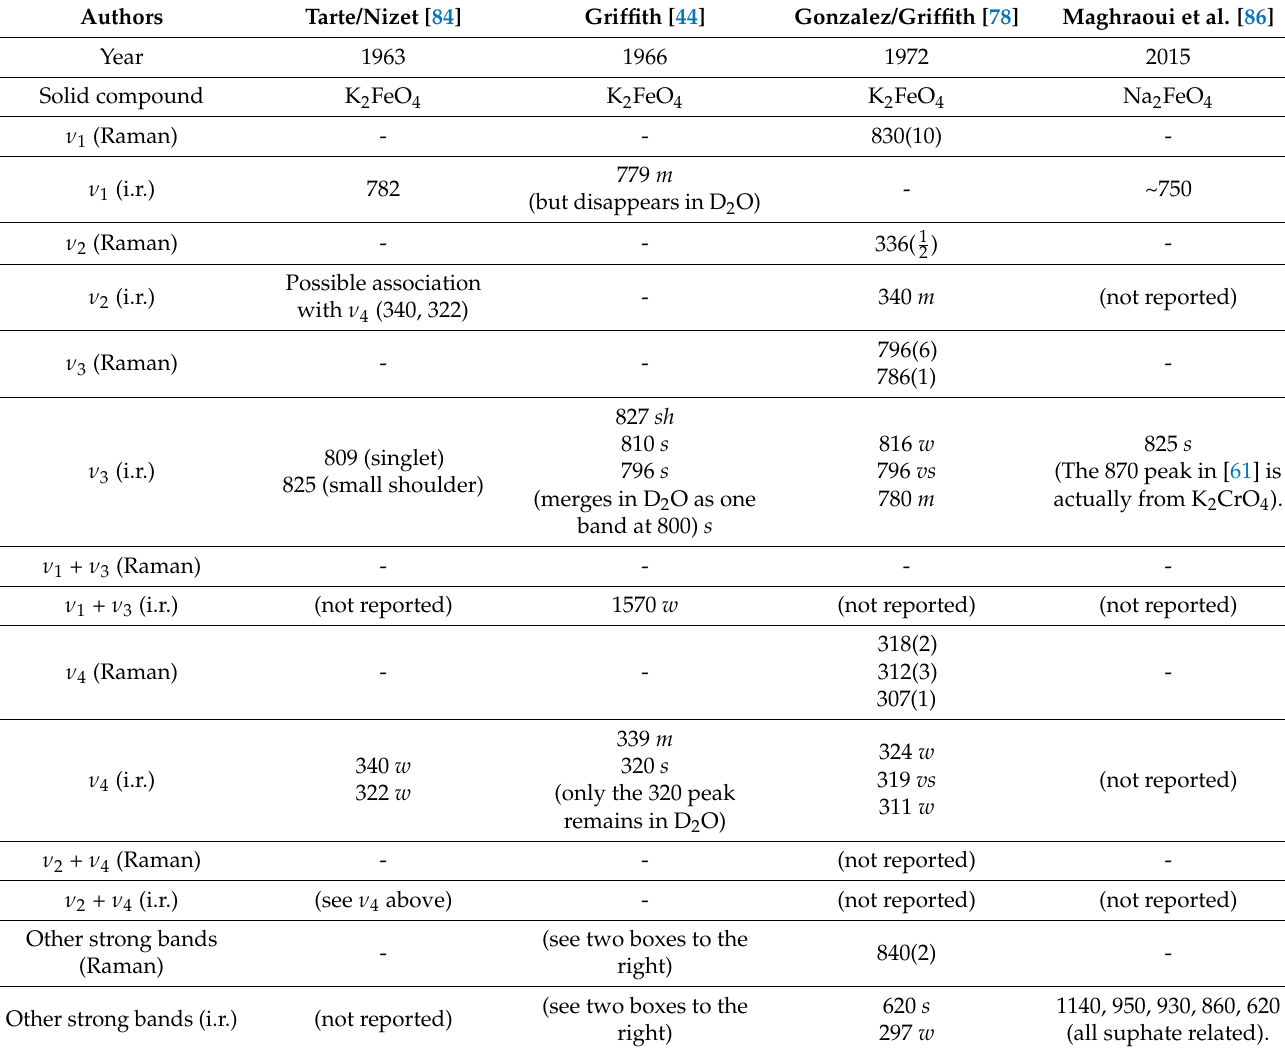
Table 1. Raman and infrared peaks of solid K 2 FeO 4 and Na 2 FeO 4 (cm − 1 ).